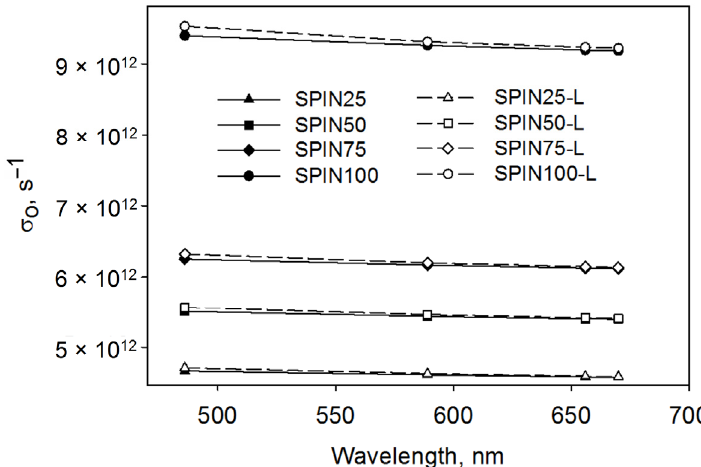
Figure 11. Optical conductivity of the PI-based supramolecular systems before and after laser ex- posure.